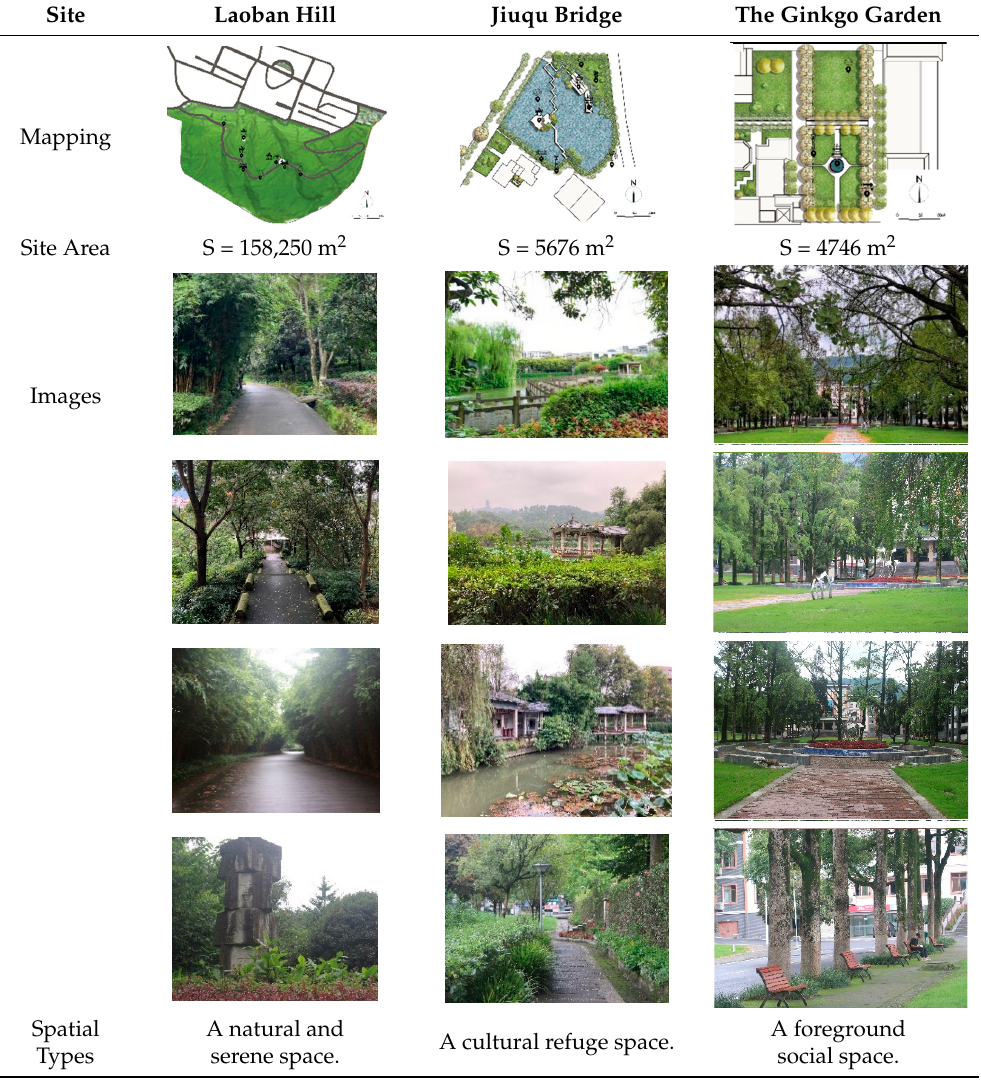
Table 1. Descriptions of Three Study Sites.